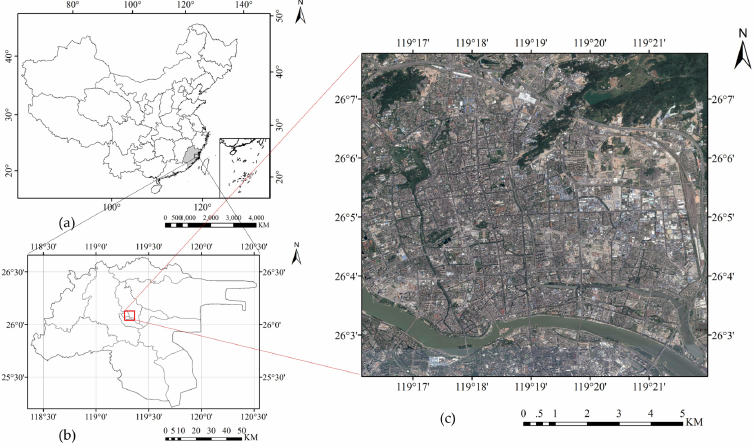
Figure 1. The location of the study area: ( a ) Fuzhou city in China; ( b ) the study area in Fuzhou city; ( c ) Google Earth image in the study